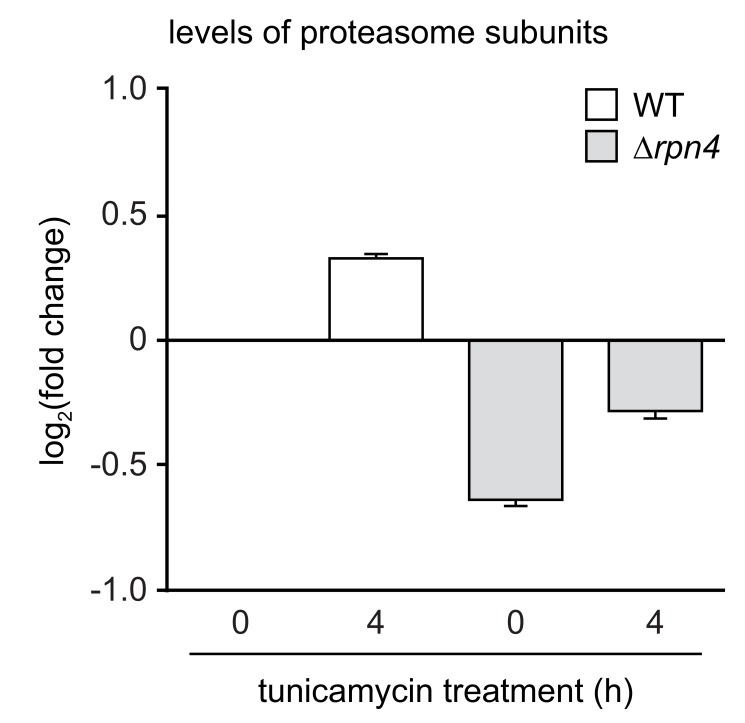
Effects of tunicamycin treatment on the levels of proteasome subunits in wild-type and ∆rpn4 cells.Wild-type (WT) and ∆rpn4 cells were left untreated (0 hr) or treated with 5 µg/ml tunicamycin for 4 hr. Proteasome subunit abundance was normalized to that in untreated WT cells (value = 0 in log2 space). Bars represent the mean log2(fold change)±SEM, n = 32. See Figure 4—source data 1 for the data used to generate the graph.